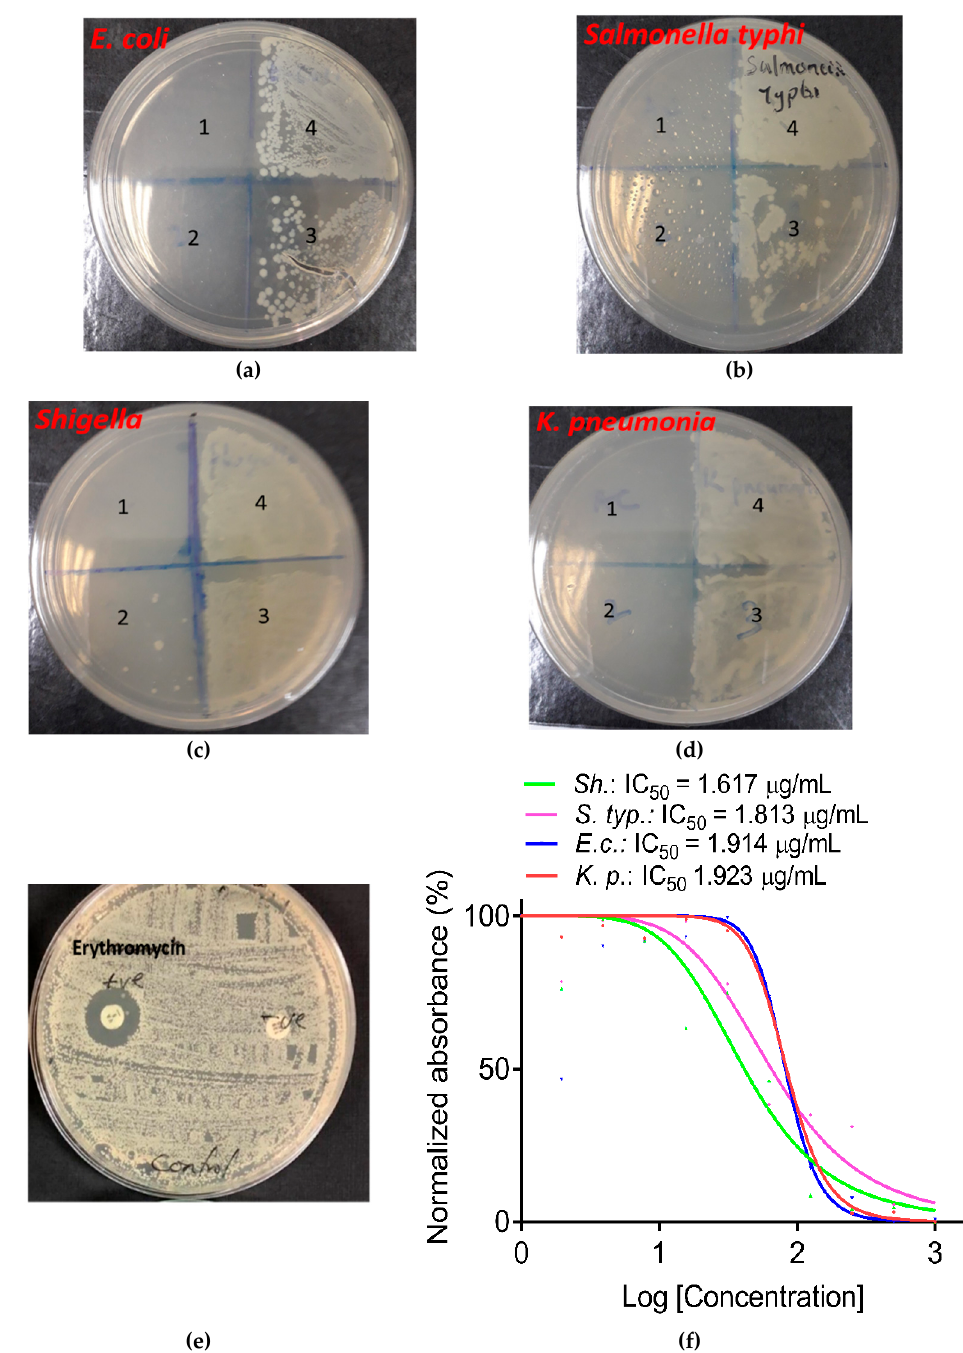
Figure 5. Absorbance of various concentrations of ( a ): E. coli , ( b ) S. typhi , ( c ): Shigella and ( d ) K. pneumonia. The absorbance was measured at 0 h and after 24 h of incubation. T: tetracycline, A: amoxycillin, and E: erythromycin were used as positive controls.